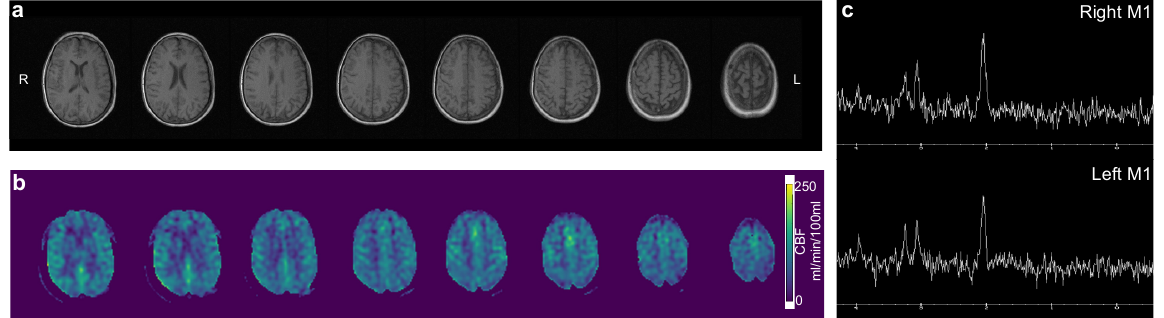
Figure 2. Routine magnetic resonance imaging with T1 weighted ( a ), arterial spin labeling perfusion imaging ( b ), and spectroscopy ( c ) revealed no apparent